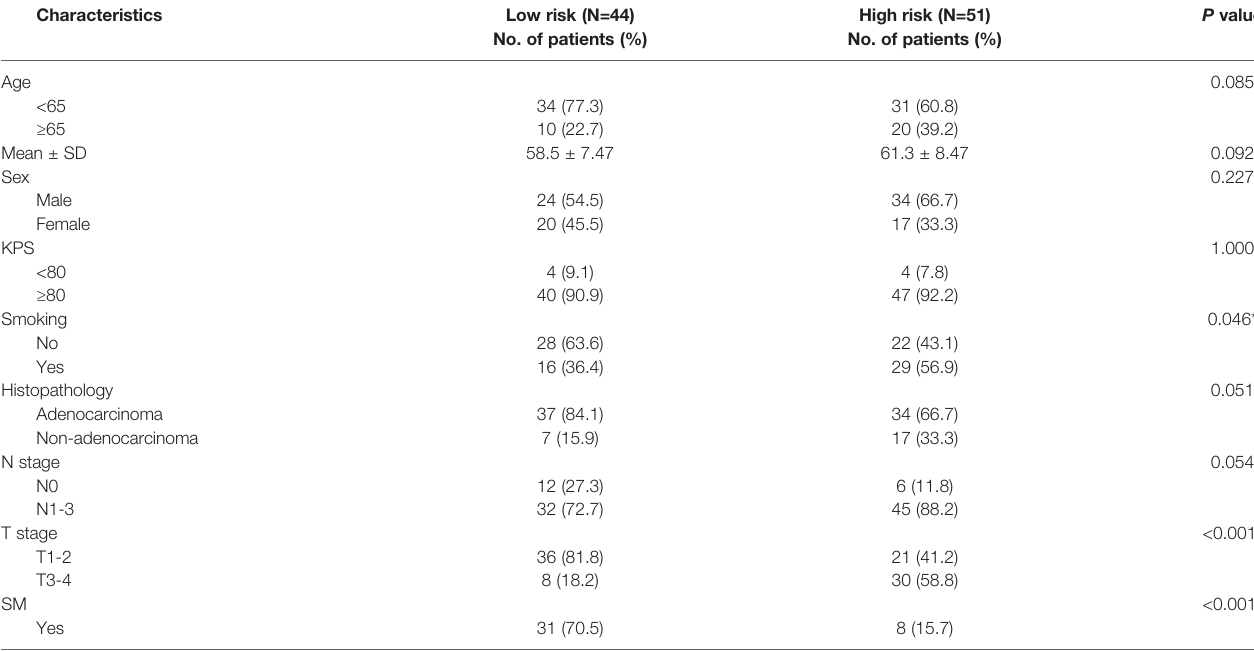
TABLE 5 | Clinical characteristics of low- and high-risk patients in the validation set.